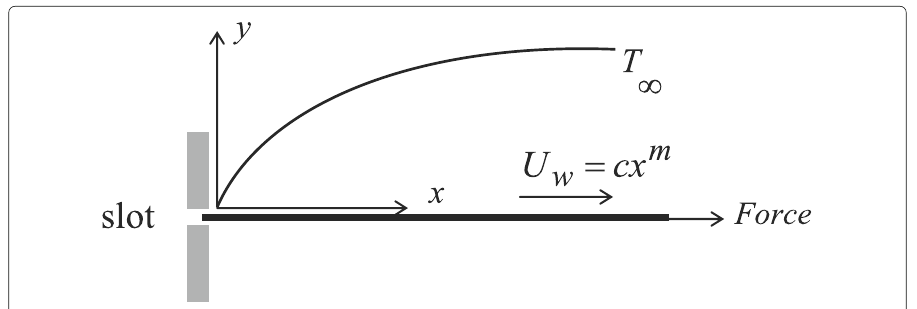
Fig. 1 Sketch of flow over nonlinearly stretching